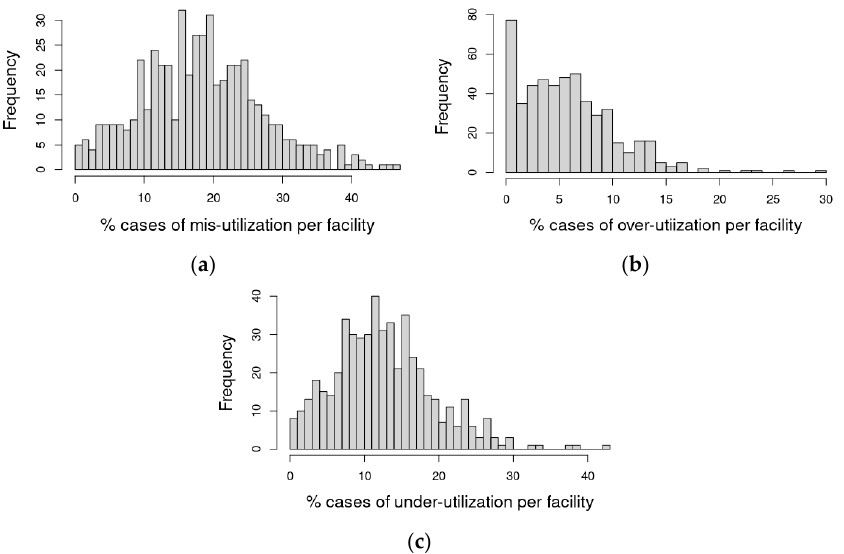
Figure 4. Histograms portraying the observed distribution of ( a ) mis-, ( b ) over-, and ( c ) under- utilization rates by facility using the multivariate logistic model (containing both patient and competing resources information) fitted probabilities and a probability threshold for utilization of 20%.